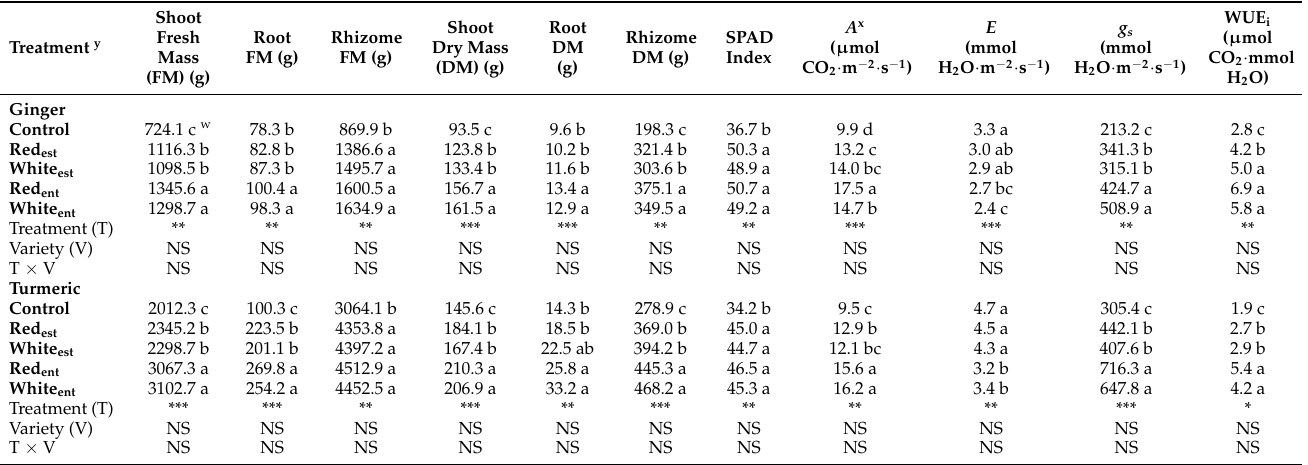
Table 4. Final growth and physiological parameters measured in two varieties of ginger and turmeric plants grown in an open field treated with white, red, or no kaolin sprays (control) during two different production stages (early establishment vs. entire cycle) in Experiment 2 z